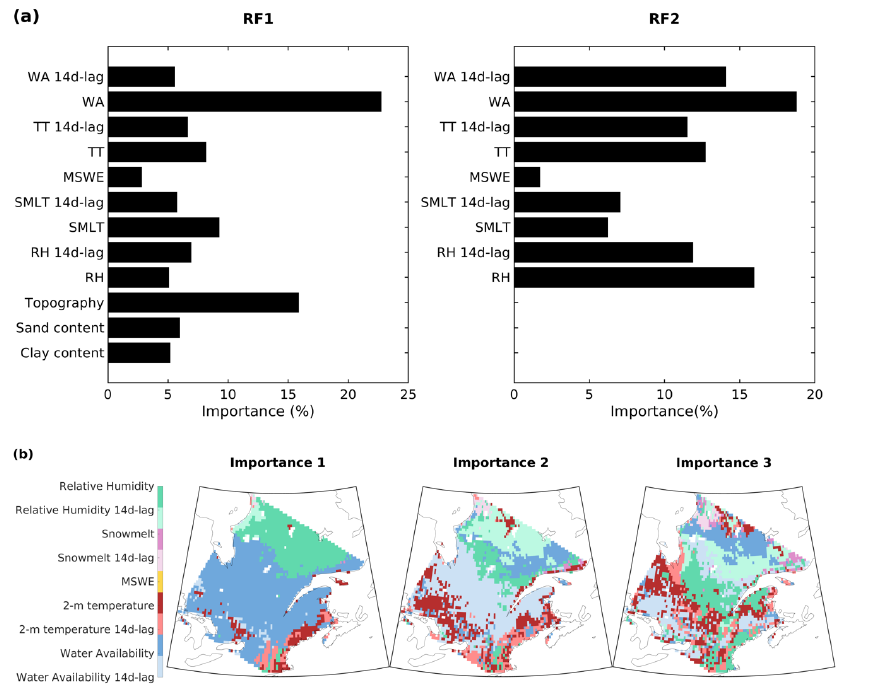
Figure 7. Mean surface soil moisture for the April–September period. ( a ) Relative importance of predictors for the RF1 model and average importance for the RF2 models. ( b ) Spatial view of the top 3 important variables for RF2. (WA: water availability; TT: 2 m temperature; MSWE: maximum snow water equivalent; SMLT: snowmelt; RH: relative